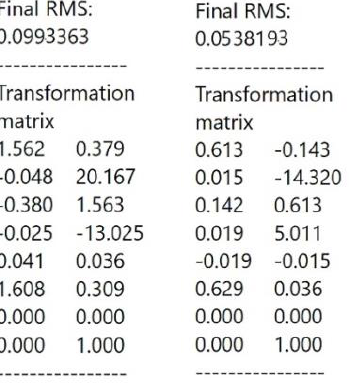
Table 1: RMS [m] value carry out comparing Low- Resolution images data set dense Cloud with the Ground Truth Source one, for façade (on the left side) and the portal (right side).